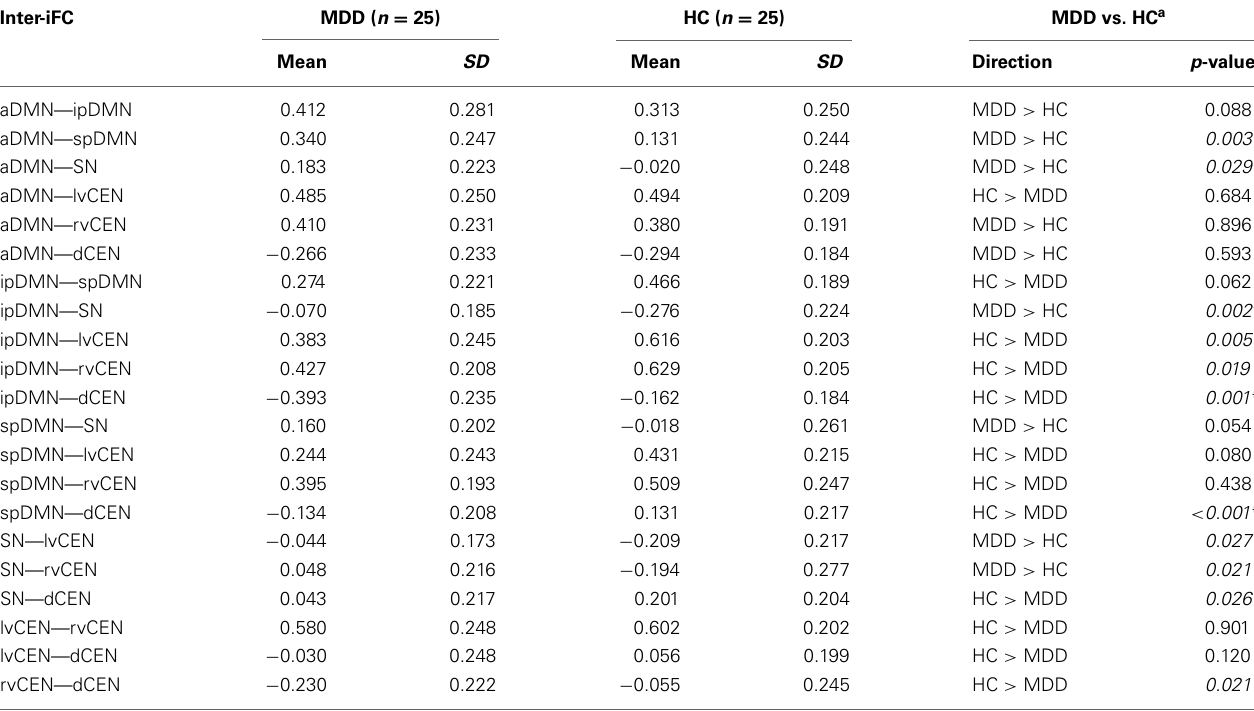
Table 4 | Inter-network intrinsic functional connectivity in patients with major depressive disorder and healthy controls. Inter-iFC MDD ( n = 25) HC ( n = 25) MDD vs. HC